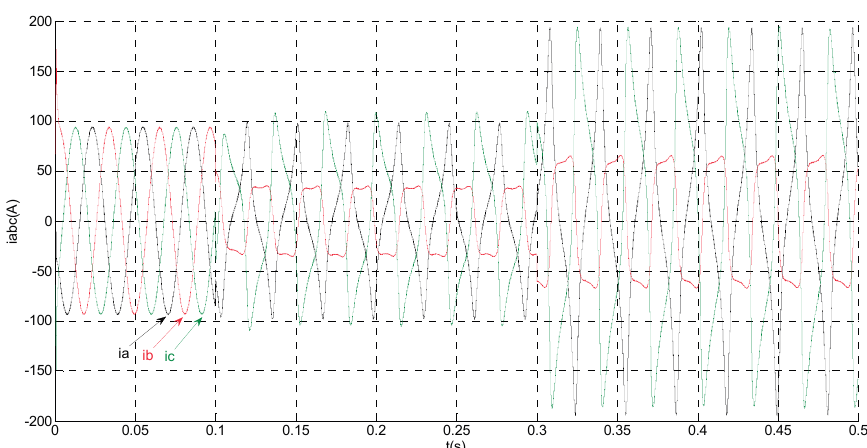
Figure 11. Simulation results of measured phase currents.